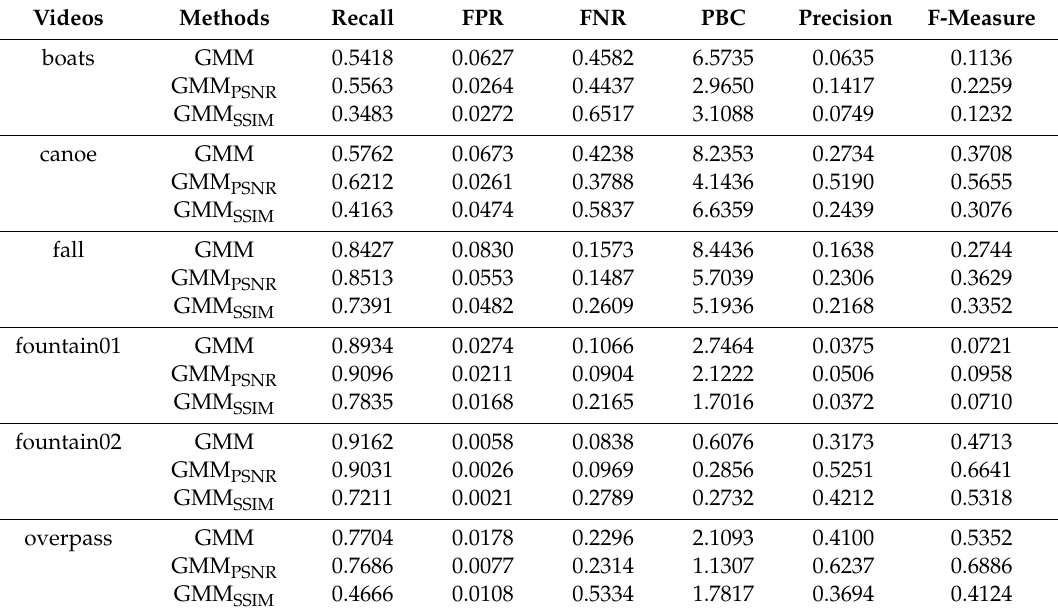
Table 8. Comparisons of PSNR and SSIM for GMM on dynamic